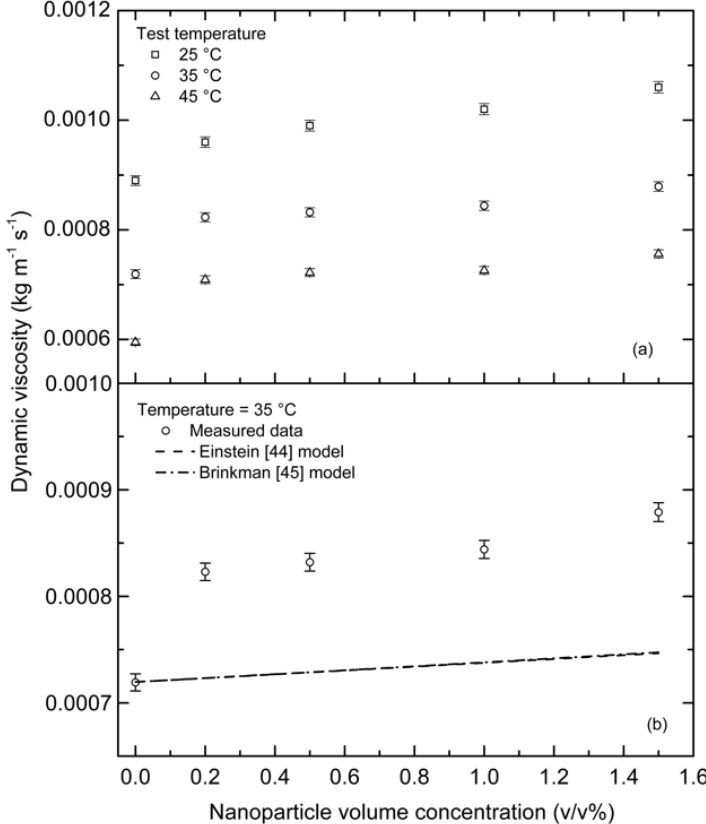
Figure 7. ( a ) Experimental dynamic viscosity of TiO 2 –W NFs as a function of temperature and NP volume concentration. ( b ) Comparison of the measured dynamic viscosity at 35 °C and that predicted by the classical models of dynamic viscosity.